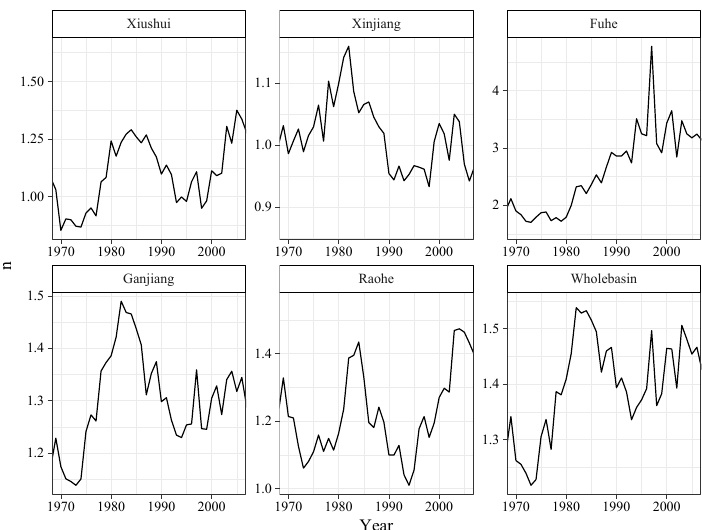
Figure 3. Temporal variation of the catchment properties’ parameter n for PYLB and each sub-basin during the period from 1960 to 2010. The annual value of n was calibrated by adapting the Budyko framework with a 10-year moving average, including the five antecedent and precedent years.